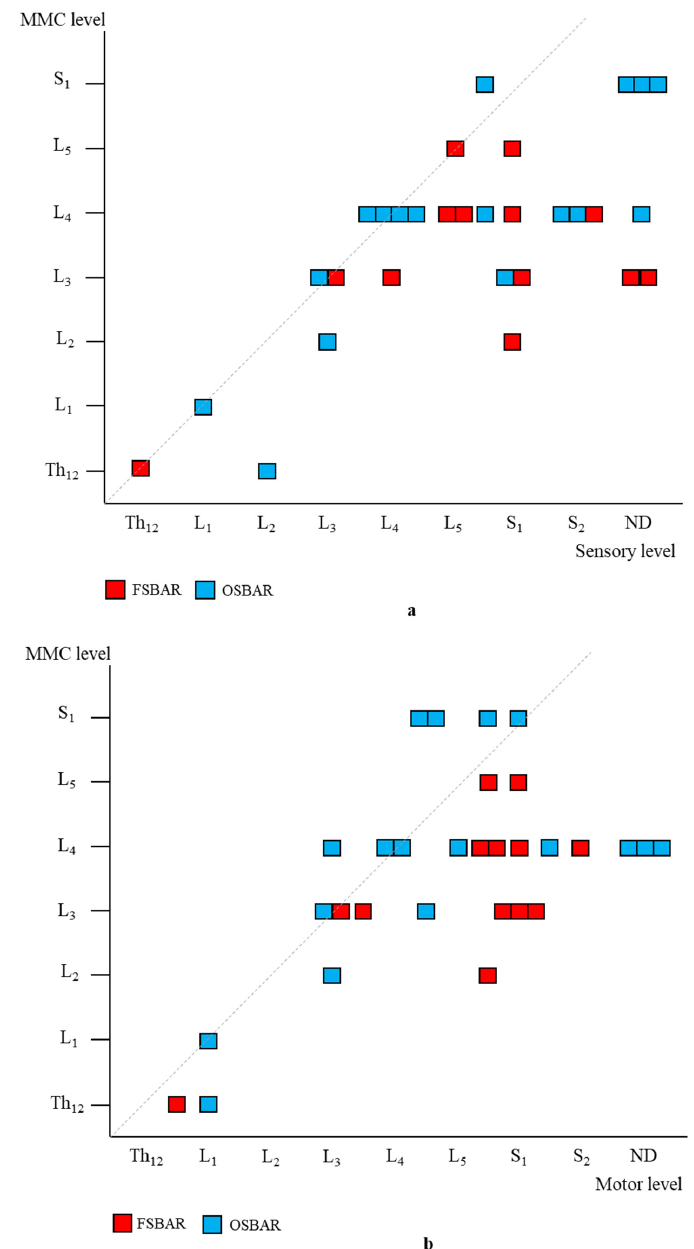
Figure 5. Segmental neurologic comparison between OSBAR and FSBAR. ( a ): Radiologic level of the fetal MMC versus segmental sensory function in OSBAR and FSBAR. ( b ): Radiologic level of the fetal MMC versus segmental motor function in OSBAR and FSBAR. The x -axis indicates the segmental neurologic function (sensory function, ( a ), and motor function, ( b )). The y -axis indicates the segmental level of the MMC. FSBAR cases are indicated by red squares, and OSBAR cases are indicated by blue squares. The dotted lines represent the expected outcomes when the segmental neurological (sensory, motor) function corresponds with the MMC level. Segmental sensory and motor function gain did not statistically differ between OSBAR and FSBAR interventions, but results after FSBAR tended to be better. Abbreviations: MMC = myelomeningocele; OSBAR = fetal intervention technique by the open approach; NSBAR = neonatal MMC